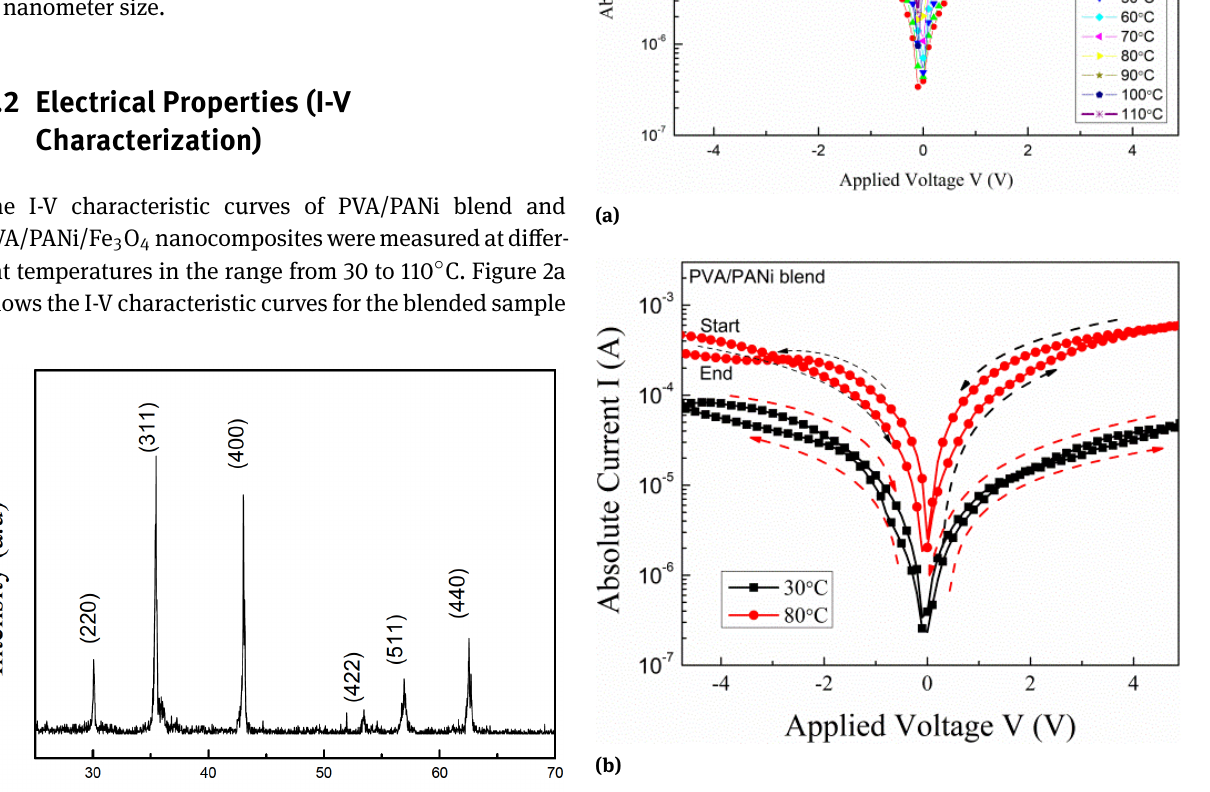
Figure 2: I-V characteristic curves for PVA/PANi blend sample a) at different temperatures b) cyclic runs at 30 and 80 ∘